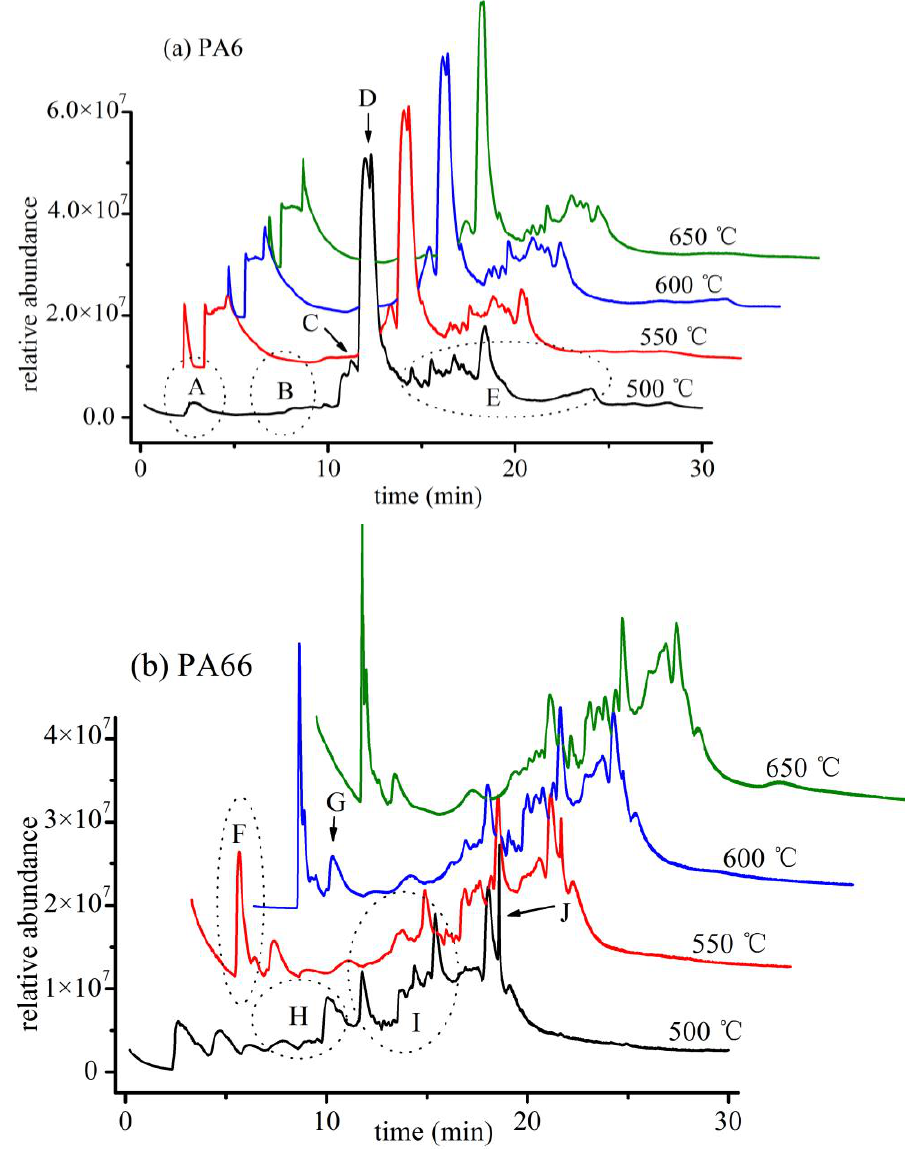
Figure 7. Total ion flow of microplastics by Py-GC/MS at different temperatures for thermal cracking: ( a ) PA6; ( b ) PA66. Region A represents carbon dioxide and propylene; region B represents 1-pentenenitrile and hexanenitrile; region C represents 6-aminohexanenitrile; region D represents caprolactam; region E represents various amides; region F represents cyclopentanone; region G represents 5-hexenamine; region H represents amines, such as 1-hexylamine and 1,6-hexanediamine; region I represents amides; and region J represents 1, 8-diazacyclotetradecane-2, 7-dione.